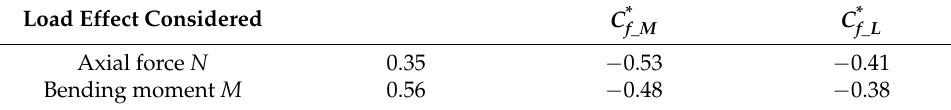
Table 2. Proposed wind force coefficients for the amin wind force resisting